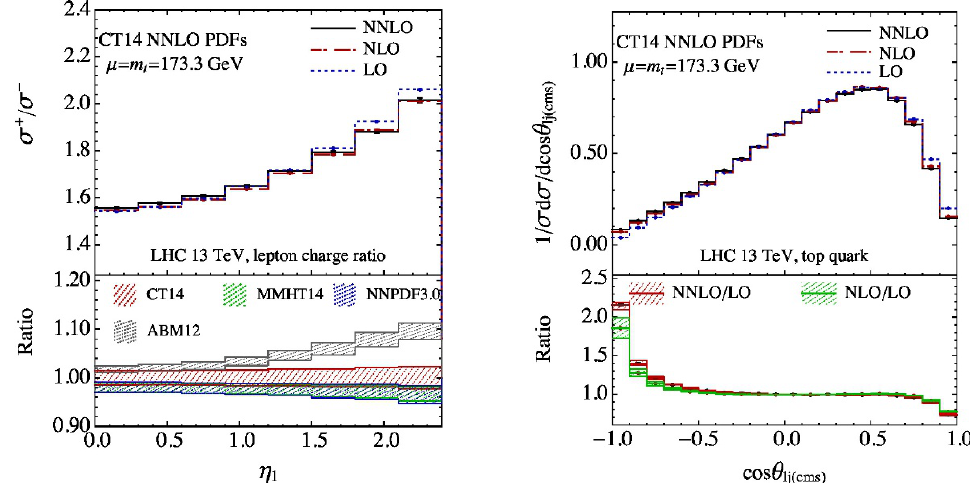
Figure 29 . Predicted lepton charge ratio as a function of the pseudo-rapidity (left plot), and normalized angular distribution between the charged lepton and the non- b jet in the rest frame of the top quark (right plot), from t -channel single top-quark production at 13 TeV after (cid:12)ducial cuts, including full